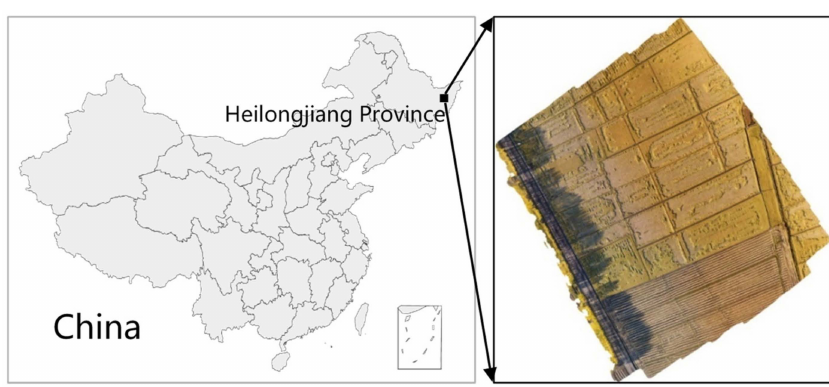
Figure 1. Schematic diagram of the study